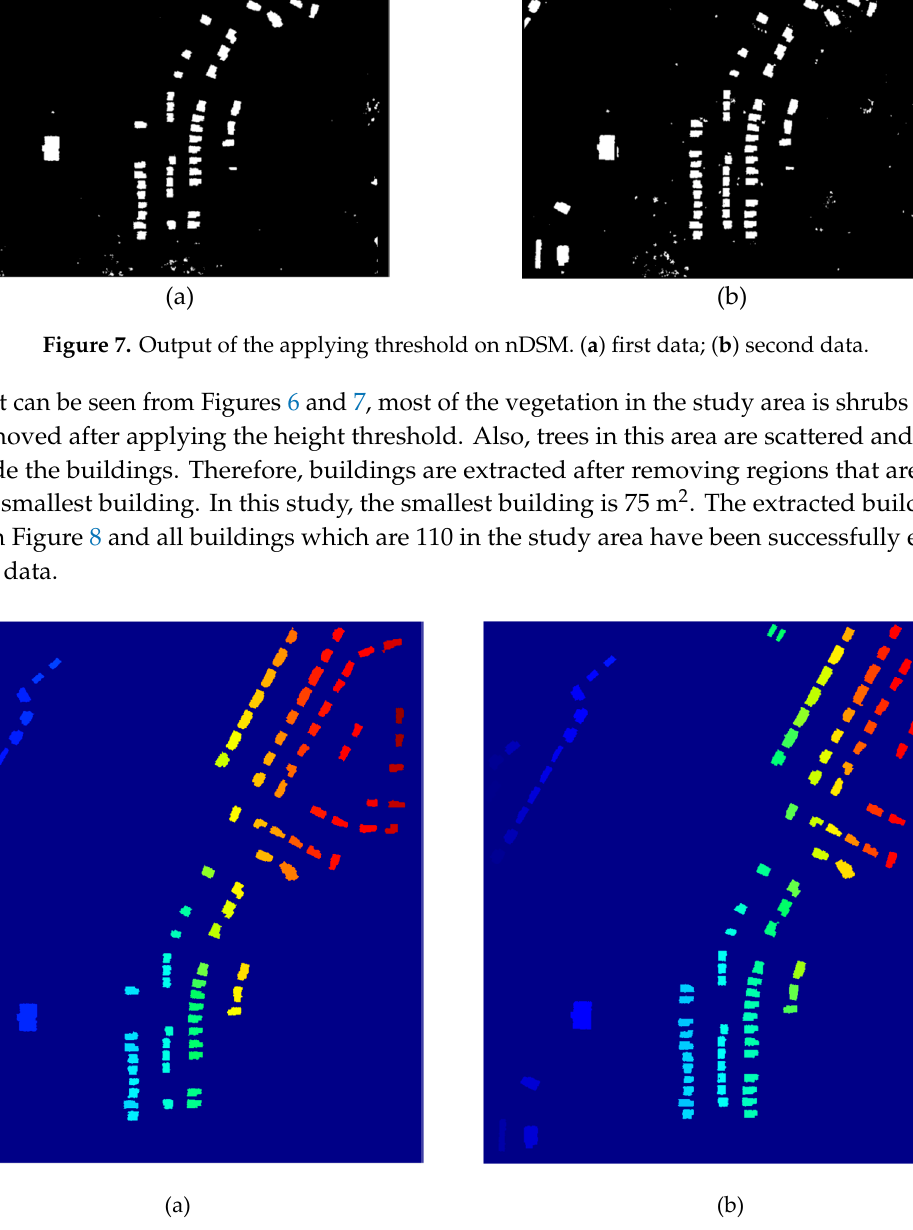
(b) Figure 9. Fitting rectangles on building regions by green color using the firefly algorithm. ( a ) First simulated rectangle and ( b ) second simulated rectangle.